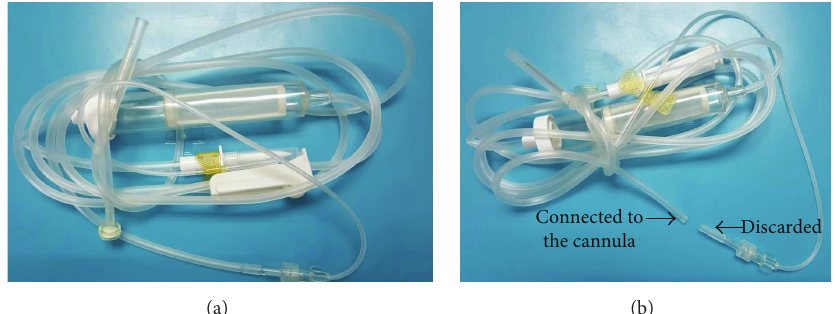
Figure 1: (a) Blood transfusion tube (model: IS-V9; Shanghai Kindly Enterprise Development Group, Shanghai, China). (b) The adaptor of the blood transfusion tube was cut. One side of the blood transfusion tube was connected to the inferior-temporal cannula after removing the valve.